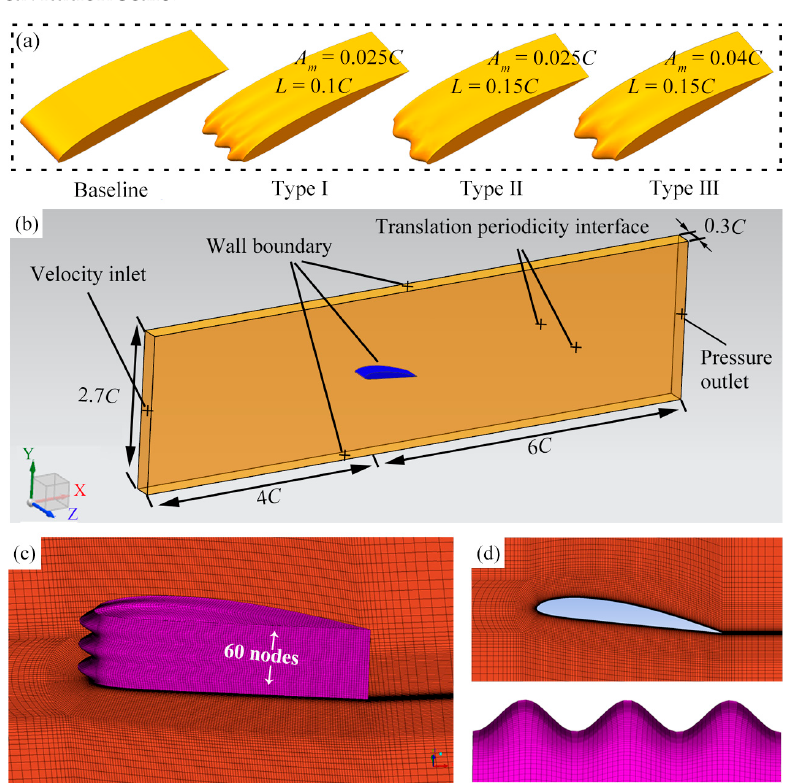
Figure 2. Geometry of baseline and modified hydrofoils ( a ), computational domain and boundary conditions ( b ), mesh layout around the blade ( c ), and local refined mesh ( d ).